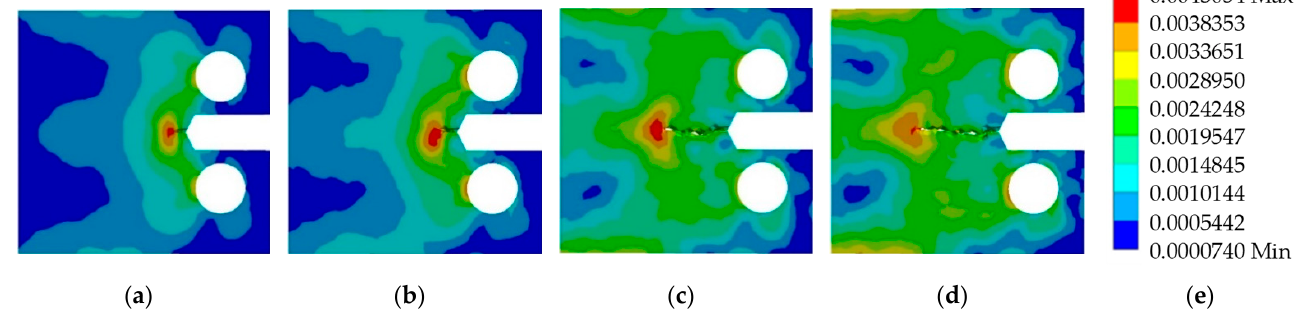
Figure 2. The equivalent elastic strain of a specimen under different tensile displacements: ( a ) 500 mm; ( b ) 700 mm; ( c ) 1500 mm; ( d ) 2000 mm; ( e ) strain scale.